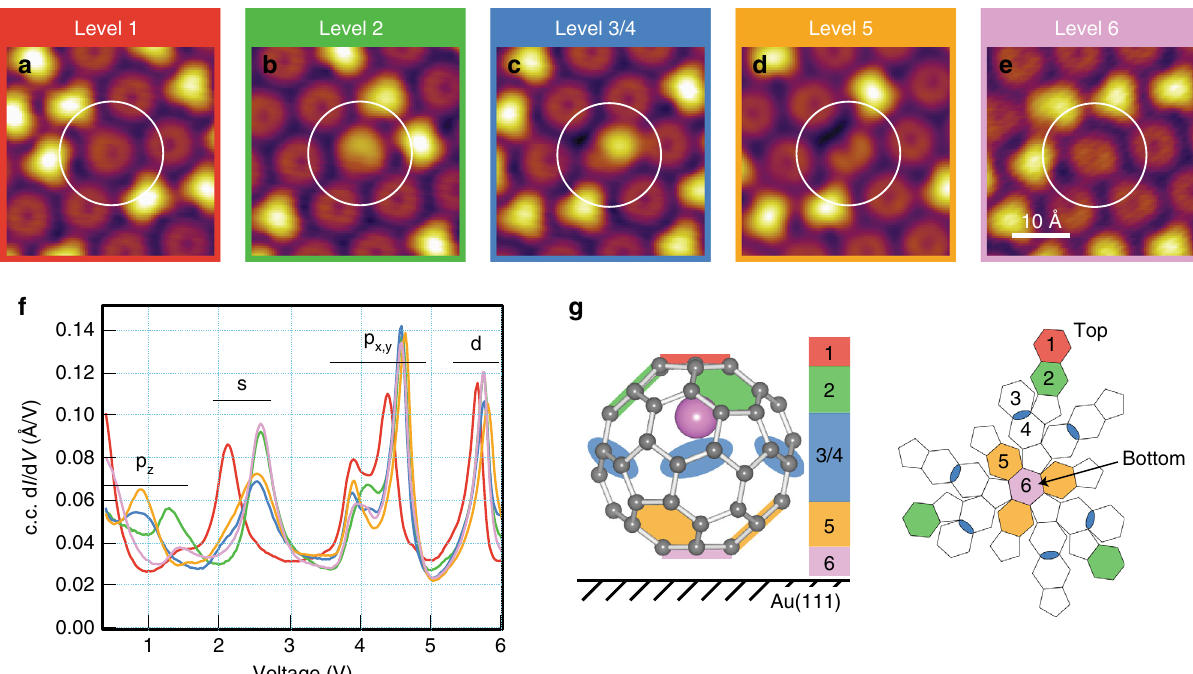
Fig. 4 Identi fi cation of 14 switched states. All STM images acquired at – 2.5 V, 0.1 nA. a Level 1: Li@C 60 in the native M-C 6 state with the Li closest to the uppermost hexagonal face. b Level 2: the bright protrusion can be seen to be located at three off-centre positions rotated by 120°, yielding three distinct states. c Levels 3 and 4 (termed level 3/4, see text): the kidney bean shape can be seen to adopt six rotational orientations, yielding six states. d Level 5: the dark depression can be seen to be located at three off-centre positions rotated by 120°, yielding three states. e Level 6: a single state similar in appearance to a but electronically different (see f ). f Constant-current d I /d V spectra for each of the species in a – e ; see also Supplementary Note 4. All data coloured according to the level they relate to. g Left : Ball-and-stick model of Li@C 60 as seen from a side perspective, and right : as a deconstructed diagram. These resemble Fig. 1a, b but are re fi ned to highlight the actual Li coordinations experimentally identi fi ed. See also Supplementary Note